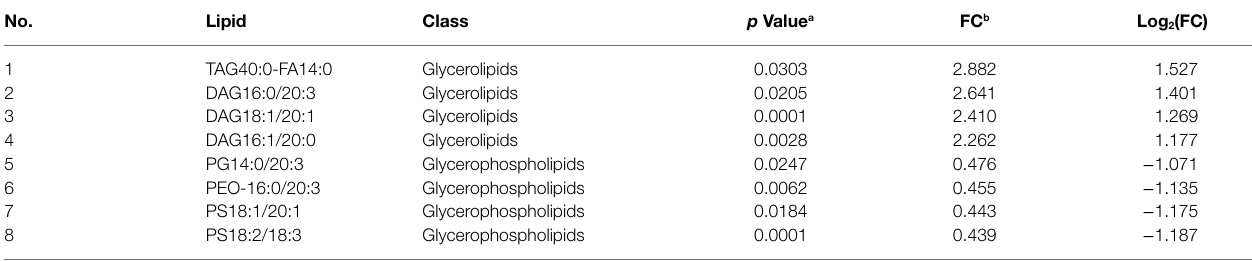
TABLE 7 | Lipids with different levels between NPC patients with a M0 stage tumor and NPC patients with a M1 stage tumor. No. Lipid Class p Value a FC b Log 2 (FC)